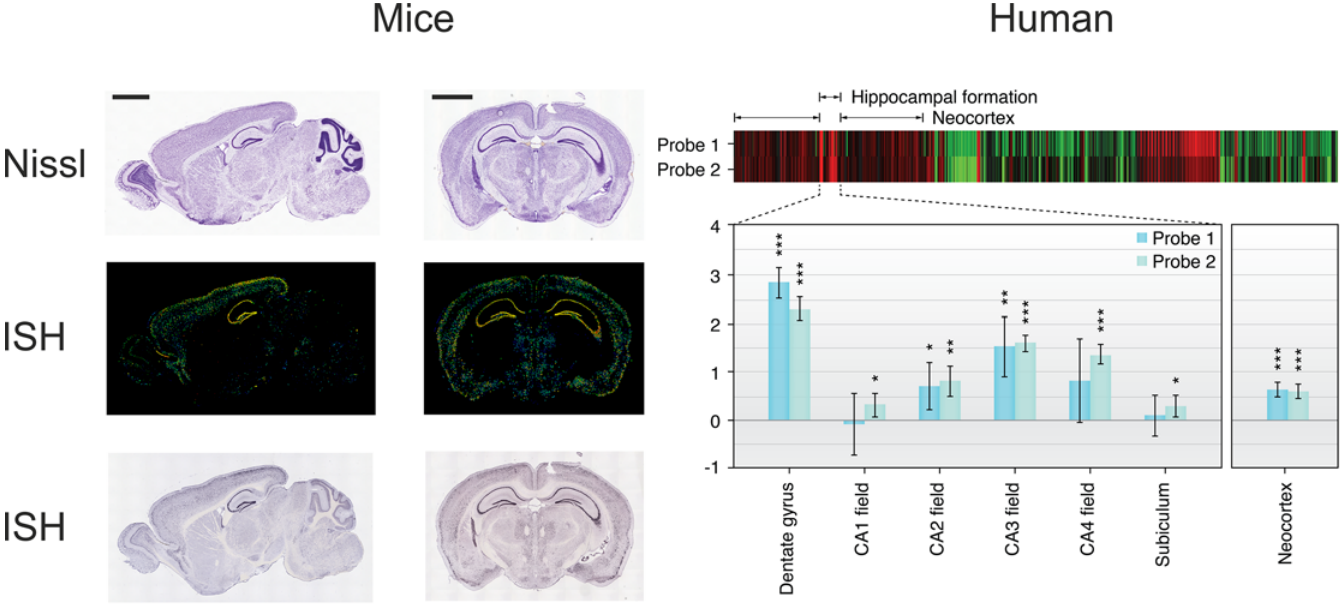
Fig 2. Gene expression of BDNF across the whole brain as assessed in Allen Brain Atlas (Seattle, WA, USA). In mice, gene expression was the highest in the DG/hippocampus as investigated by In Situ Hybridization (ISH), where warm colors indicate high expression. Note that contrast and brightness were enhanced in original images to increase visibility of the effects here. Black bars correspond to 2 mm. Gene expression in humans is shown as individually normalized gene expression ( Z -scores normalized to whole human brain expression). The heat map shows scores across the whole human brain and for each of the six subjects contained in the database beside each other, where red indicates high and green indicates low expression. Bars represent mean normalized gene expression and standard deviation across one female and five male subjects included. Search conducted on 17 th October 2014 for human and on 9 th October 2014 for mice data. *** P < 0.001; ** P < 0.01; * P < 0.05, two-tailed Student ’ s t -test against 0. For details on the methods we refer to Mueller et al .[53]